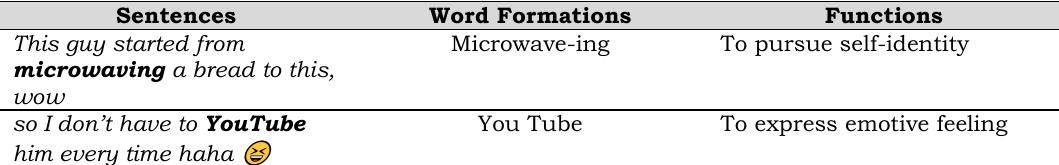
Table 5. Coinage word formation and function